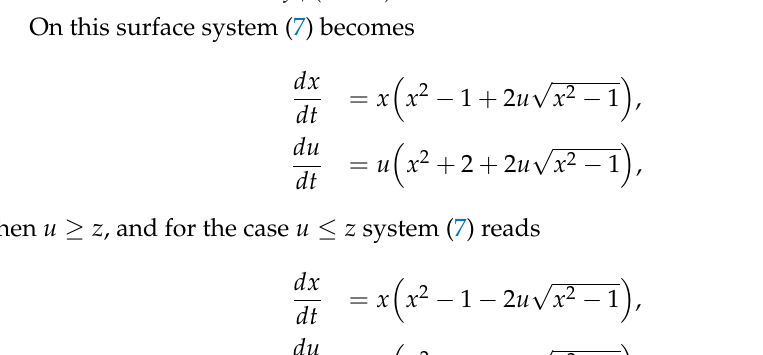
Figure 5. The phase portrait on the invariant plane u = 0 restricted to the region x 2 − z 2 ≤ 1 inside the Poincaré disc for different values of s : ( a ) 0 < s < 1, ( b ) s = 1, ( c ) 1 < s < √ ( e ) s >